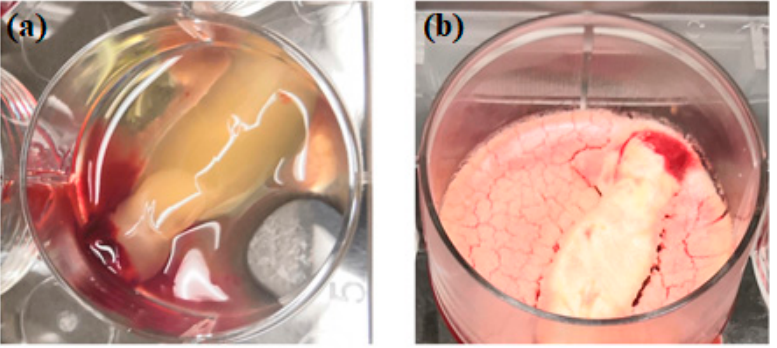
Figure 2. Physical comparison of traditionally prepared platelet concentrates ( a ) versus lyophilized platelet concentrates ( b ).